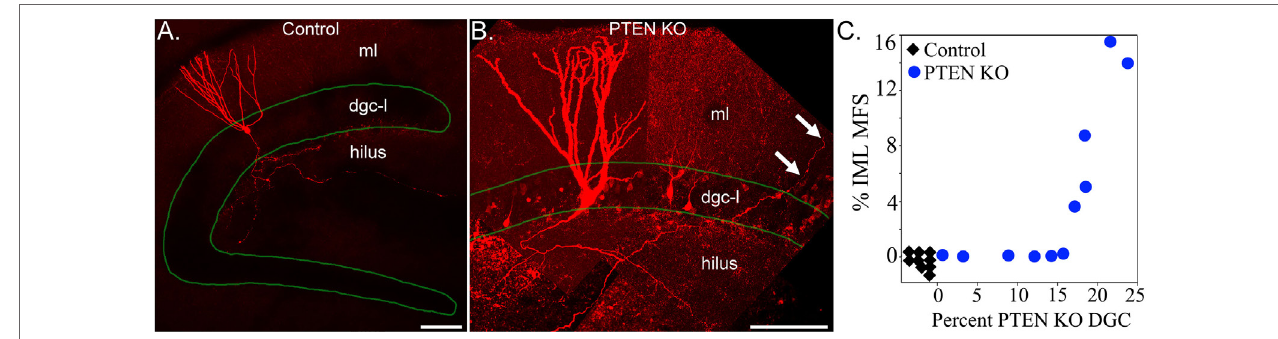
FiGURe 2 | Confocal reconstructions of biocytin-filled hippocampal granule cells from a control (A) and a phosphatase and tensin homolog (PTEN) knockout (B) mouse. Labeled granule cells are shown in red, while the dentate granule cell body layer (dgc-l) borders are outlined in green. Note that the axons of the control cell are confined to the dentate hilus, while the PTEN knockout cell sends an axon collateral into the molecular layer (arrows). ml, dentate molecular layer. Scale bars = 100 µm. (C) Correlation between the degree of mossy fiber sprouting (mfs), assessed by ZnT3 immunoreactivity in the inner molecular layer (iml), and the percentage of PTEN KO granule cells. PTEN knockout cells and mossy fiber sprouting were absent from control animals ( n = 9, black diamonds). Note the abrupt transition between animals with < 15% PTEN knockout cells and no sprouting, and animals with deletion rates > 15% and extensive sprouting. Figure reproduced in part from Pun et al.